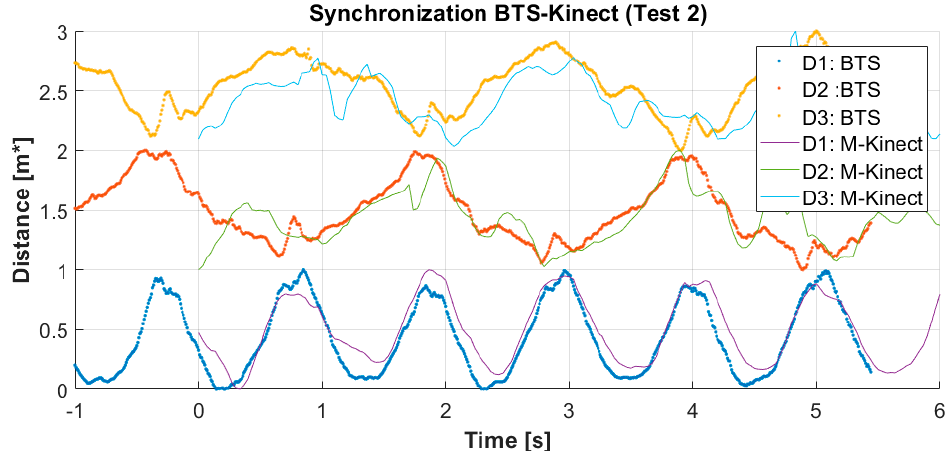
Figure 7. Example of distances D1, D2, and D3 measured using the datasets in Table 1 as a function of time, after alignment using correlation. Dots indicate the reference (BTS) system, which lines the M-Kinect system.